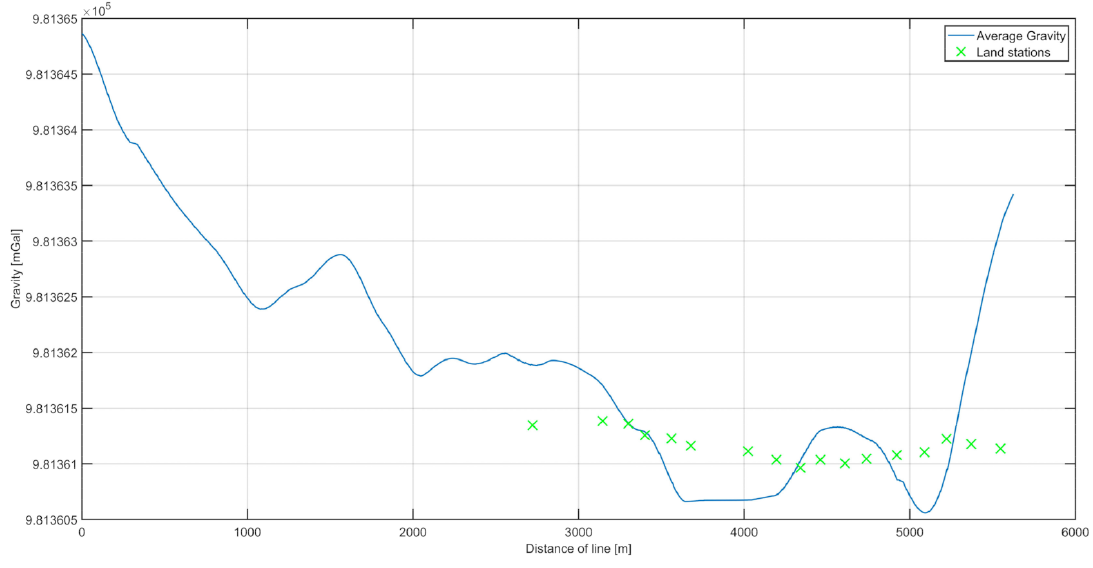
Figure 10. The mean measurements on the river, and data recorded at land-based measuring points.